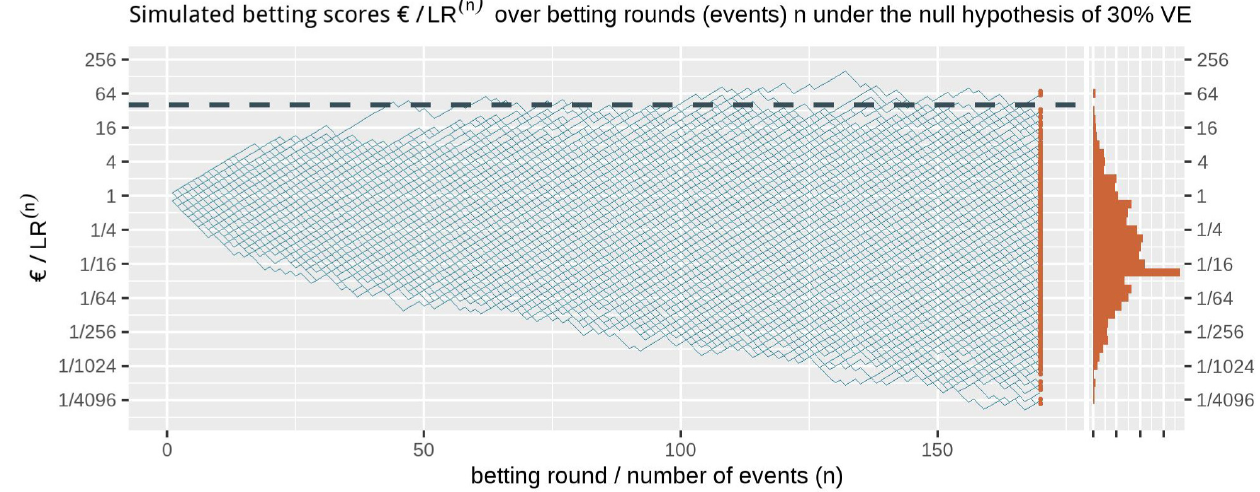
Figure 1. 1000 simulated betting scores in the FDA game over betting rounds n assuming a probability of 0.41 (70/170) for each event to occur in the vaccine group (the null hypothesis of 30% VE). The dashed line is the threshold 1/ α = 40 one-sided. The histogram at the right shows the betting score/ LR (170) after 170 events. Note that the expectation of 1 of the scores is not the mode of its distribution nor its median and that the y-axis is on a log